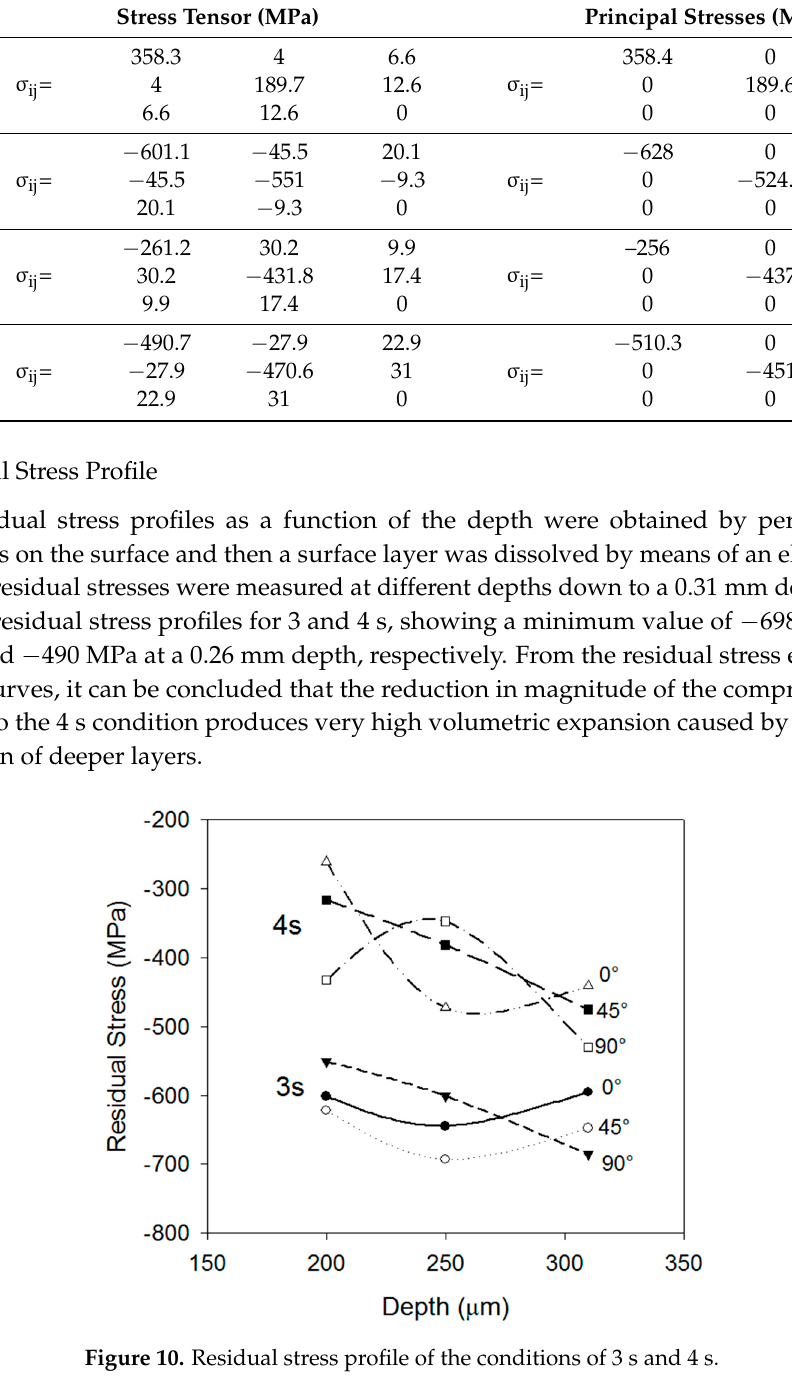
The shallow hardening induced compressive residual stresses at the surface. From the slope of the d-spacing vs Sin 2 ψ , it was concluded that the conditions of 3, 4, and 5 s resulted in compressive residual stresses and this was corroborated with the uniaxial and biaxial stress